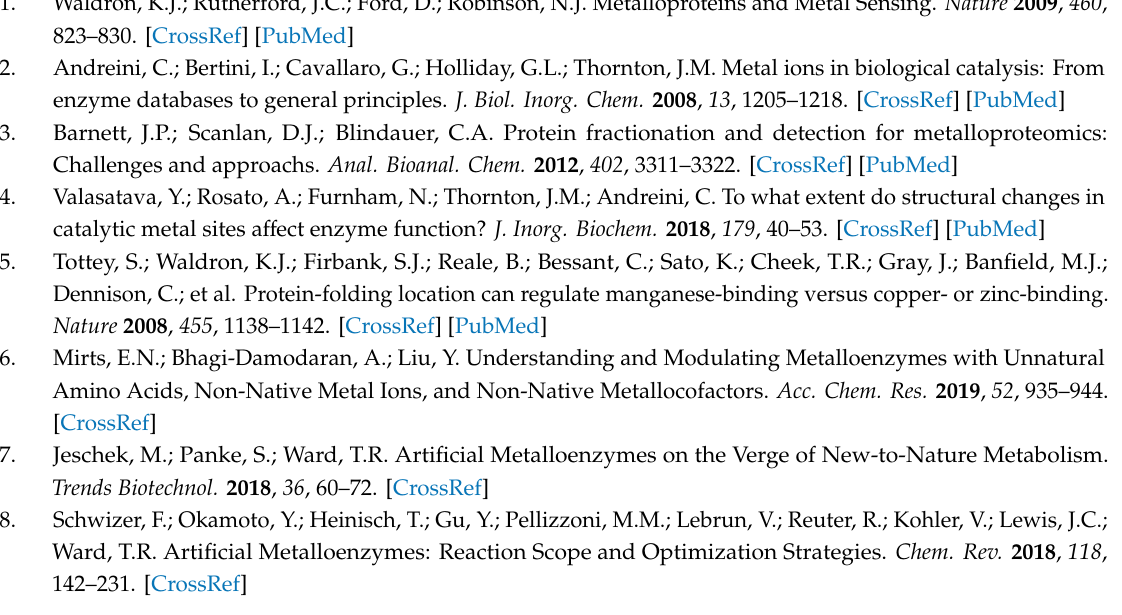
Supplementary Materials: The following are available online, Figure S1: Photograph of binuclear copper(II) complex 2 (CCDC No. 1984261). Figure S2: Single crystal X-ray di ff raction data showing additional coordination of the axial acetate carbonyl oxygen to Cu(II). Scheme S1: Proposed positive allosteric mechanism for the formation of binuclear copper(II) complex 2 . Figure S3: .cif and X-ray crystallographic experimental data. Table S1. Crystal data and structure refinement for 2 . Table S2. Atomic coordinates and equivalent isotropic displacement parameters for 2 . Table S3. Bond lengths and angles for 2 . Table S4. Anisotropic displacement parameters for 2 . Table S5. Hydrogen coordinates and isotropic displacement parameters for 2 . Table S6. Torsion angles for 2